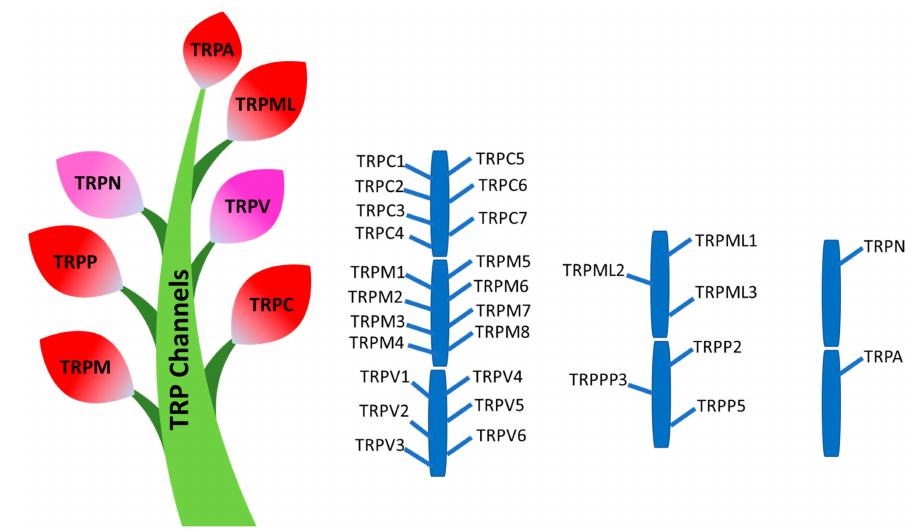
Figure 2. The human phylogenetic tree of the TRP channel superfamily. TRPC (canonical), TRPV (Vanilloid), TRPML (Mucolipin), TRPP (Polycystin), TRPM (Melastatin), TRPA (Ankyrin), and TRPN (NOMPC). TRPC2 is a pseudogene in human. TRPN is expressed in fish.